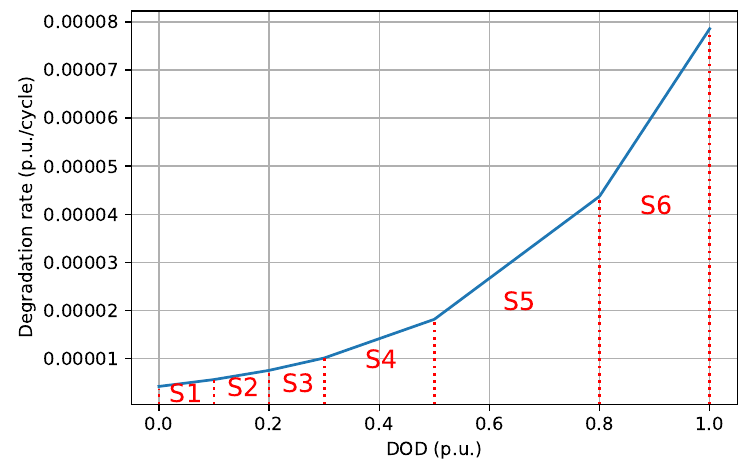
Figure 3. Linear segments of the Li-ion BESS degradation rate